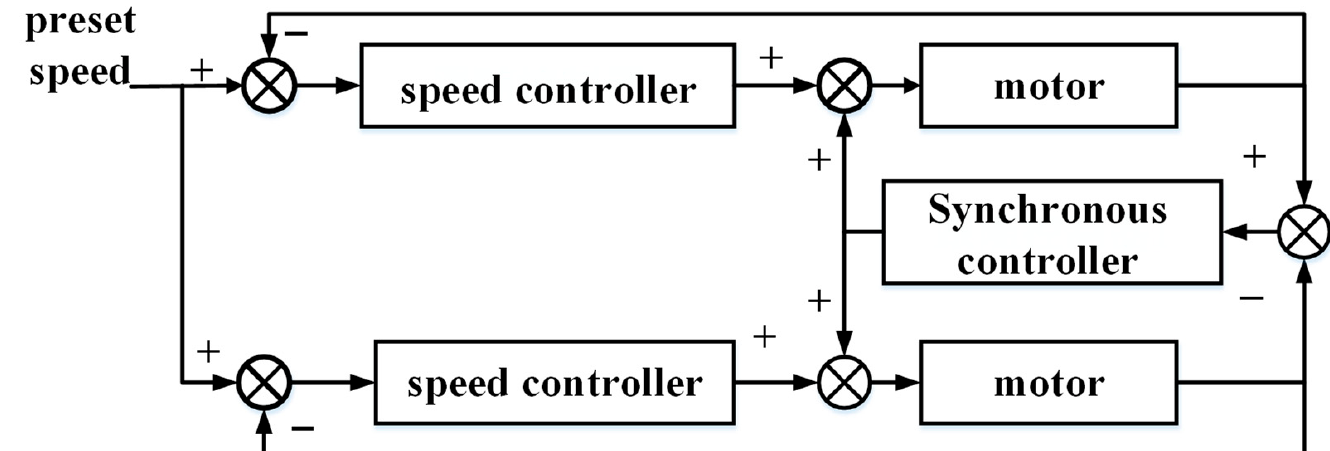
Figure 7. Cross-coupling structure diagram.